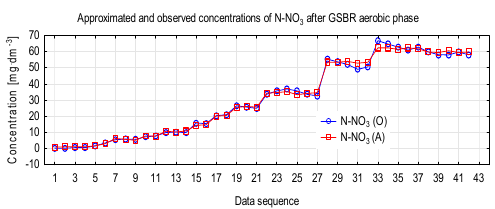
Figure 2. Approximated and observed concentrations of N-NO 3 after sequence bath reactor with aerobic granular activated sludge (GSBR) aerobic phase.